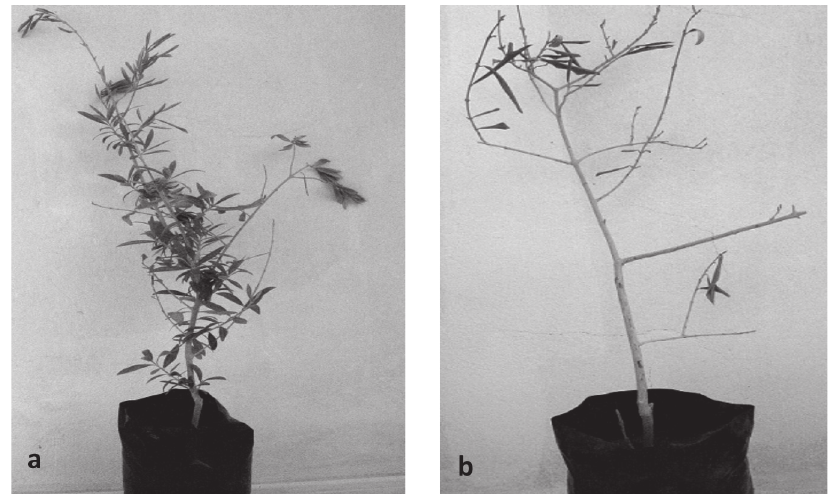
Figure 3. Symptoms induced by inoculation of olive plants with Verticillium dahliae : a, plant inoculated with isolate Z showing wilting on the branch; b, plant inoculated with isolate V a1